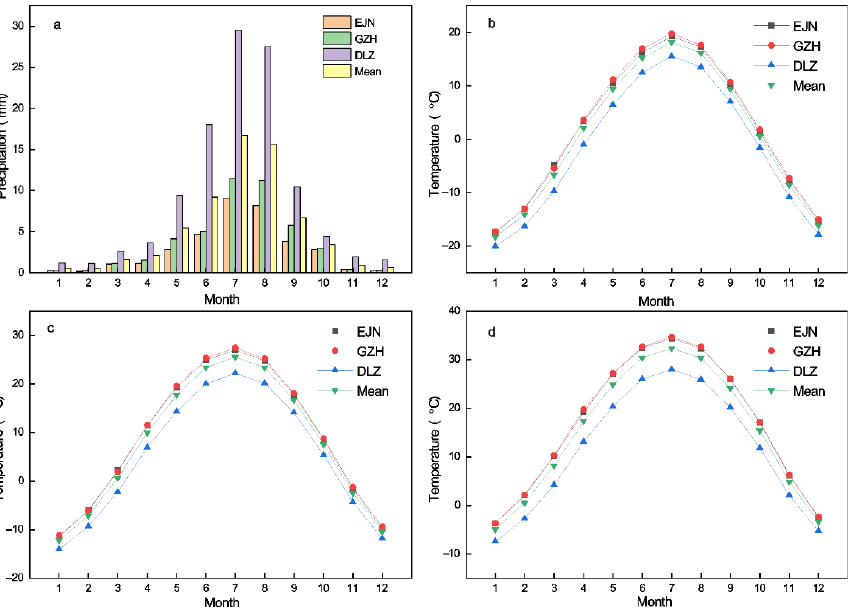
Figure 2. Monthly total precipitation ( a ), mean minimum temperature ( b ), mean temperature ( c ) and mean maximum temperature ( d ) at EJN, GZH, DLZ stations.